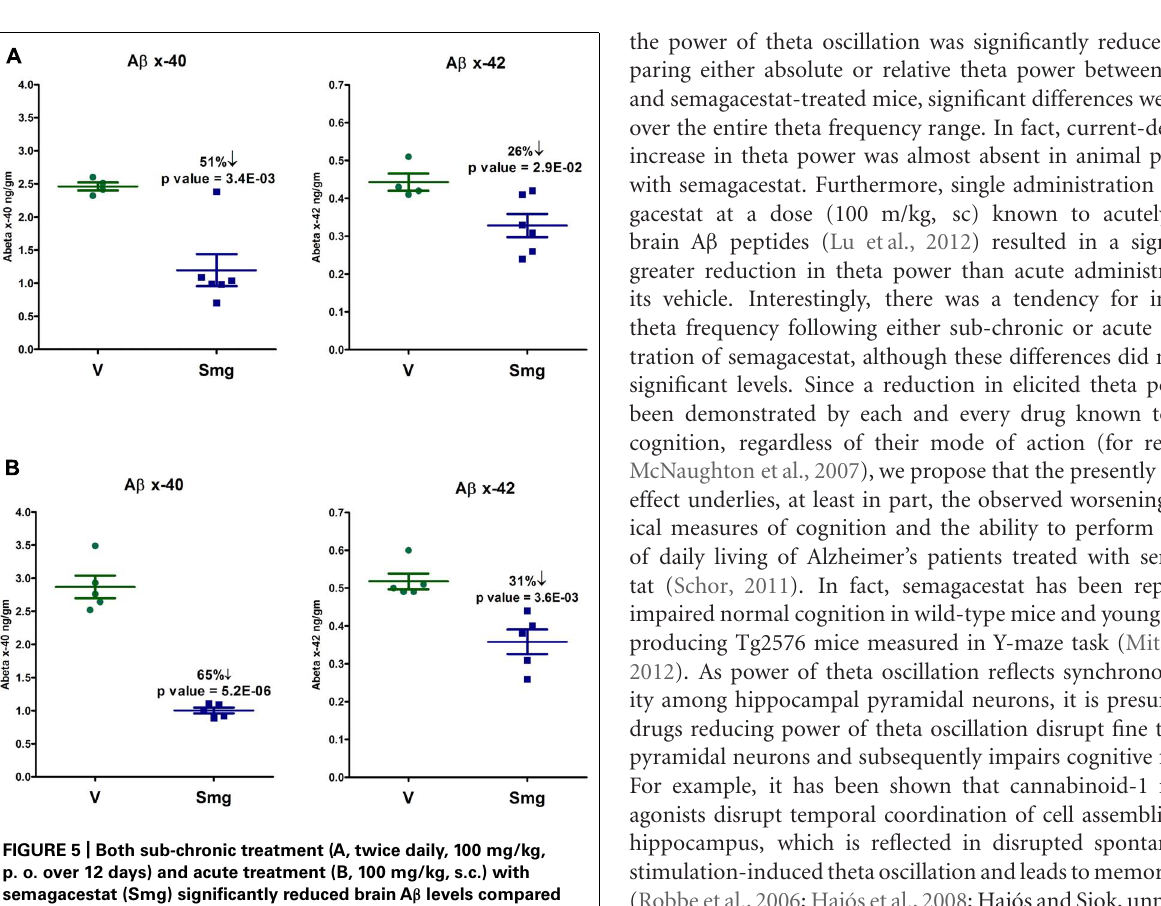
compound concentrations were 0.14 + 0.03 and 4.9 + 0.5 μ